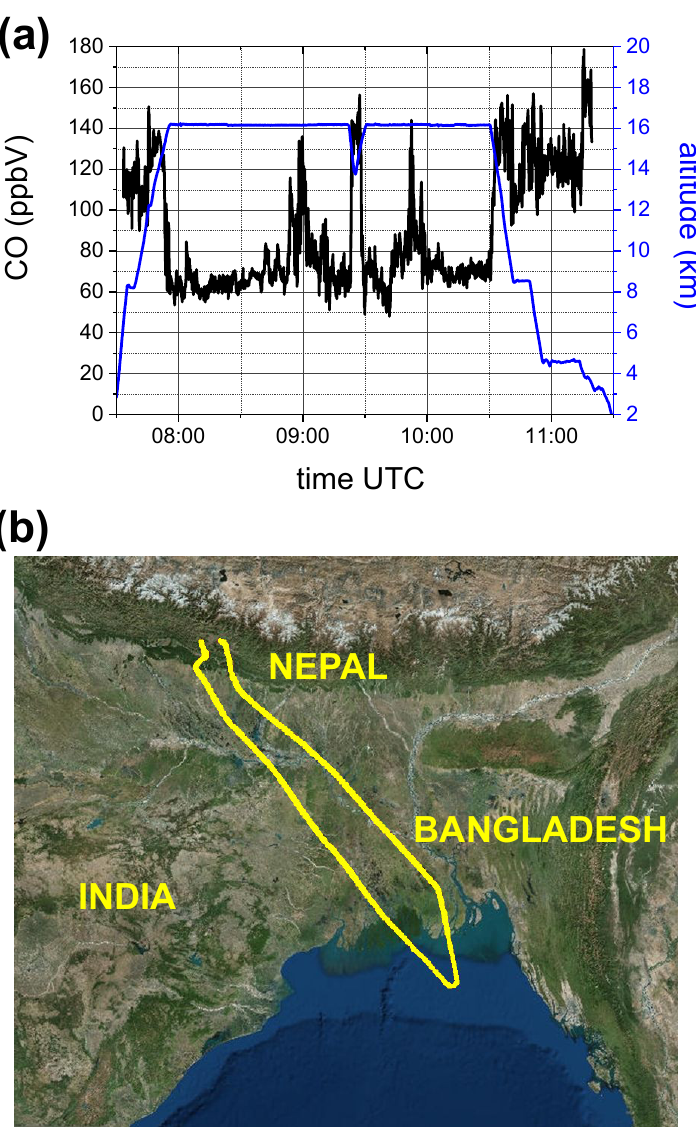
Figure 10. ( a ) COLD2 results on board the M55 stratospheric aircraft during the flight on the 6th August 2017 of the StratoClim campaign from Katmandu (Nepal). CO mixing ratio (black line) and aircraft altitude (blue line) vs UTC time. ( b ) map of the M55